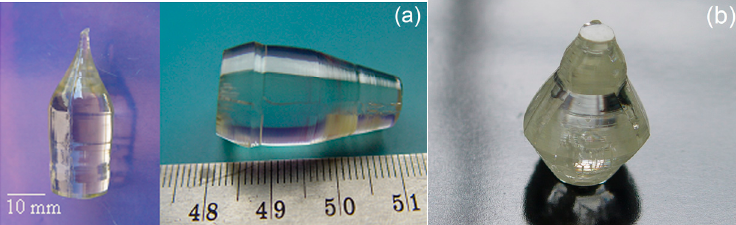
Figure 3. Near-stoichiometric LiNbO 3 crystals grown from ( a ) Li-rich melt (nSLN_L) and ( b ) K 2 O solvent (nSLN_K).